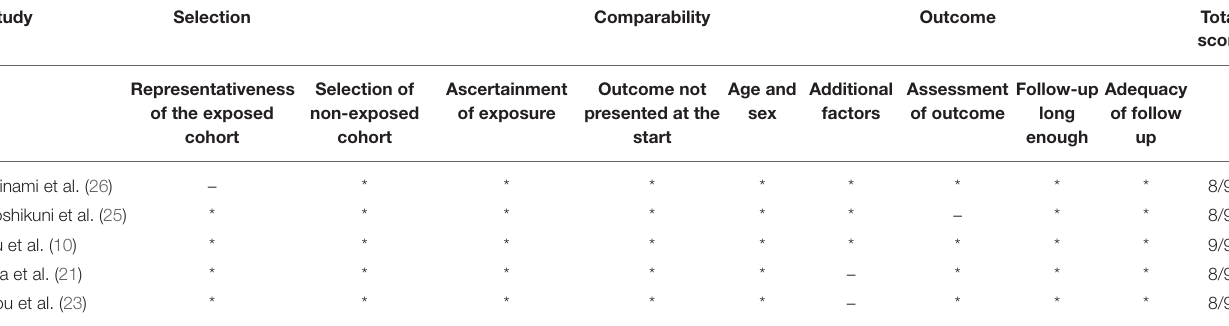
TABLE 2 | Outcome of assessment of the quality of nonrandomised studies using the Newcastle-Ottawa scale study.